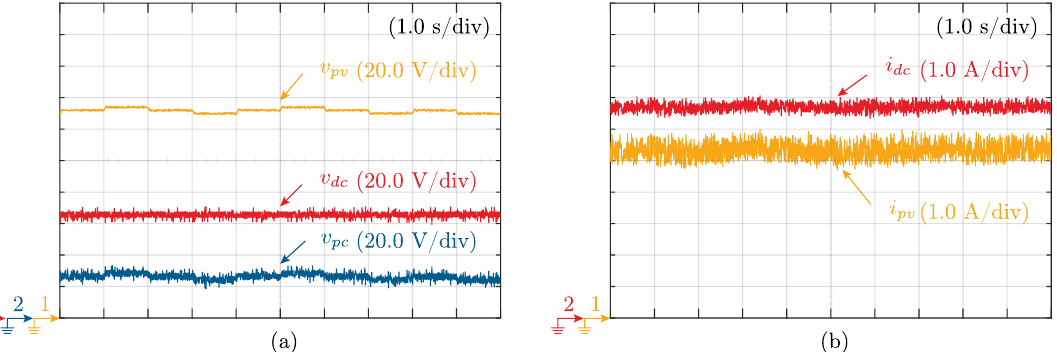
Figure 9. Experimental results under constant solar irradiation. ( a ) Voltage waveforms at the PV side, dc-link side and converter voltage; ( b ) Input and output current